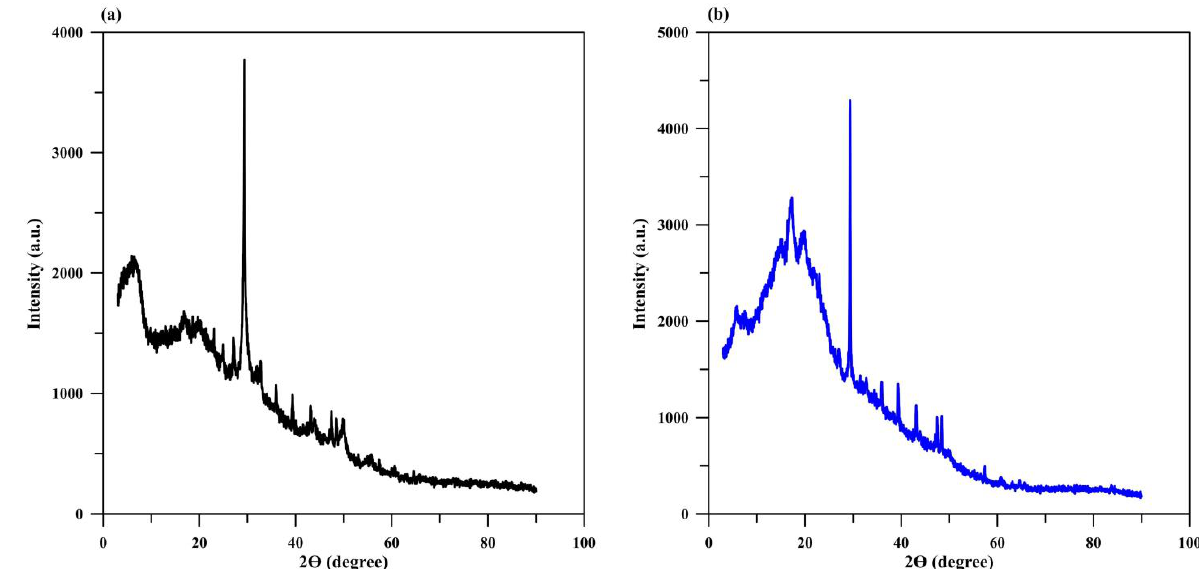
Figure 3. XRD patterns of Cry – CSH ( a ) before and ( b ) after phosphate adsorption. The FTIR spectra of the Cry – CSH column before and after phosphate adsorption are displayed in Figure 4. The O – H stretching absorption band of hydroxyl groups in starch and water molecules [10] remains in position at 3288 cm − 1 both before and after phosphate adsorption. Similarly, the C – H stretching absorption bands in starch molecules remain in position at 2926 cm −1 [10]. The absorption band at 1643 cm −1 was attributed to H – O – H bending in water molecules in CSH which may overlap with C – O bending in amylopectin in starch [10,49,50]. The remaining intense band at ~998 cm −1 before and after phosphate adsorption was attributed to O – Si – O stretching vibrations from CSH molecules [10,34], which overlap with C – O – H bending in amylopectin [49 – 51]. The highly intense band of Cry – CSH after adsorption at ~1077 cm − 1 can be attributed to the C – O, C – C, and O – H bond stretching bands of starch [49 – 51] that may overlap with the vibration bands of H 2 PO 4 – and HPO 42 – commonly appearing at 1038 cm −1 [33] or 1046 cm −1 [35].